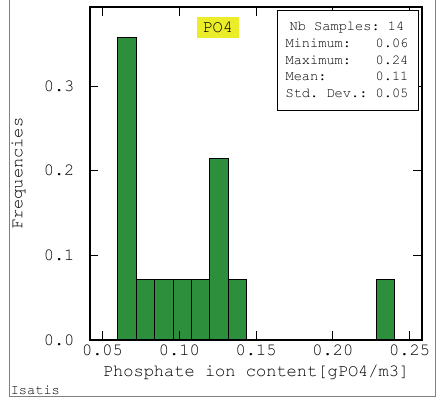
Fig. 4. Histogram of distribution of manganese Mn ++ content [g Mn ++ /m 3 ] in underground water for water intake area of Kłodzko (SW part of Poland); data coming from 14 wells + 3 piezometers